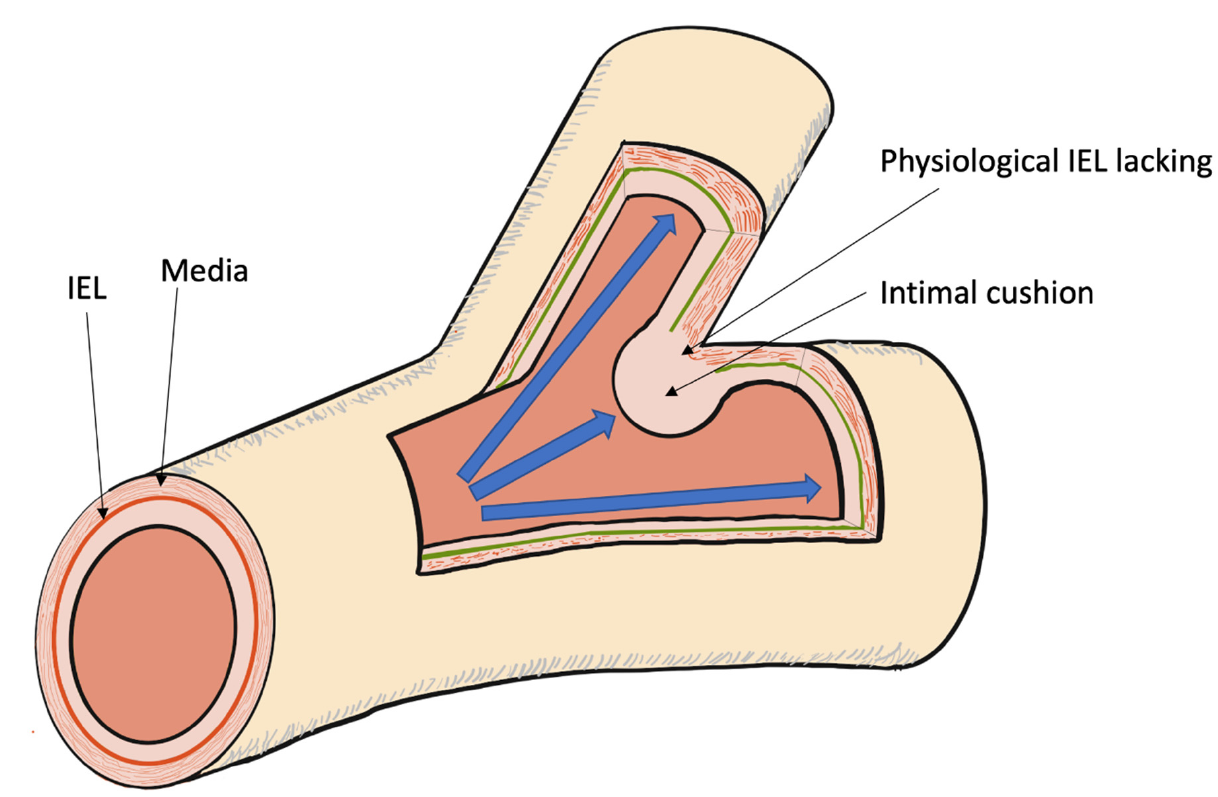
Figure 1. The medial gap or the physiological loss of internal elastic lamina.